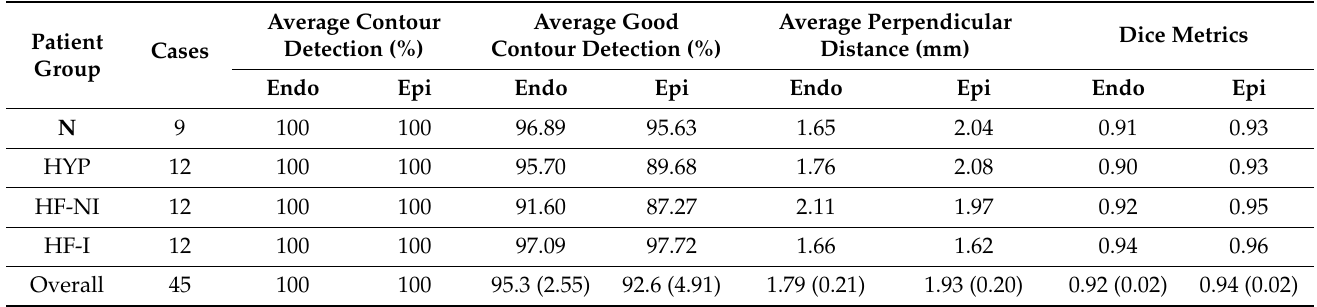
Table 7. Performance evaluation parameters for dice loss and Elu activation.